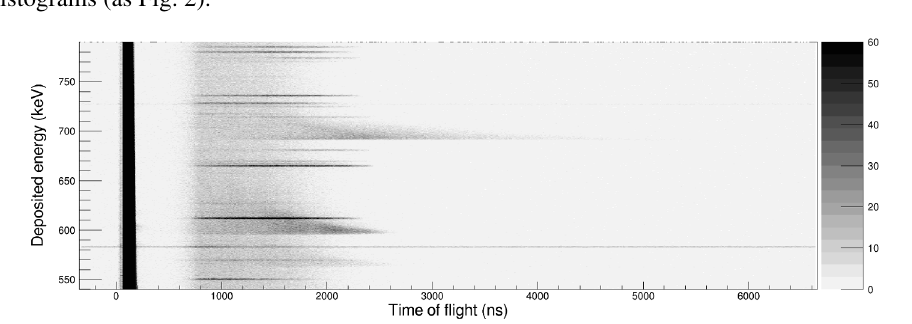
Figure 2. An example of a time-of-flight vs. deposited energy matrix, from data collected with one of the GRAPhEME HPGe